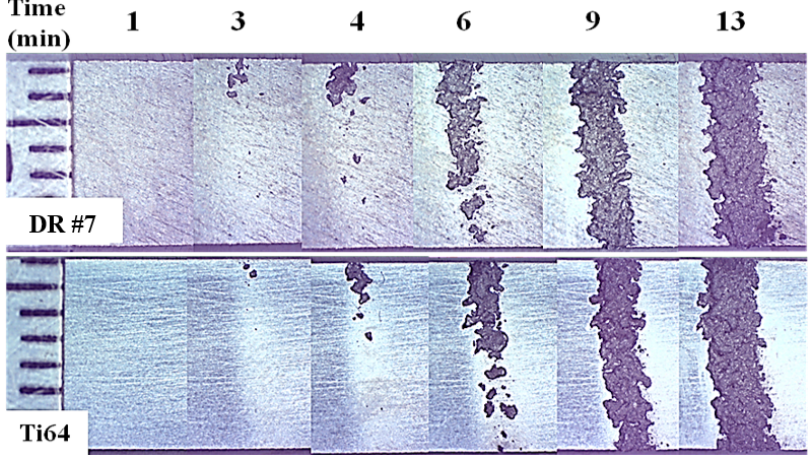
Figure 12. Macrographs of test 2 show the change in the exposed surface of DR #7 and